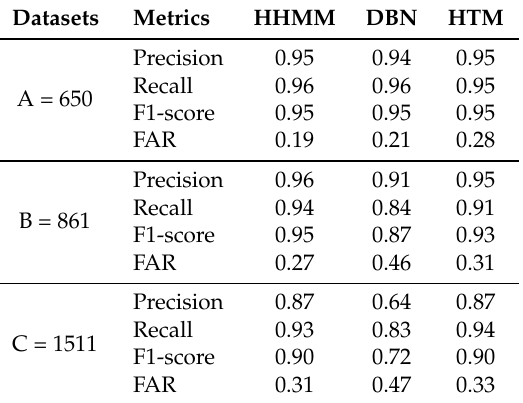
Table 8. Validation results of three datasets.